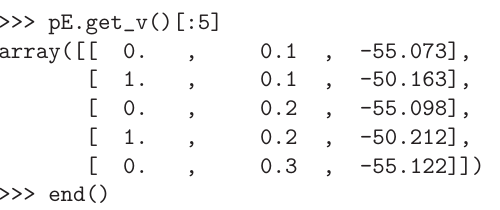
small numerical integration differences. (B) Spiking activity of excitatory (black) and inhibitory (green) neurons. Each dot represents a spike and each row of dots a different neuron. All 5000 neurons are shown. (C) Distribution of pooled inter-spike intervals (ISIs) for excitatory and inhibitory neurons. (D) Distribution over neurons of the coeffi cient of variation of the ISI